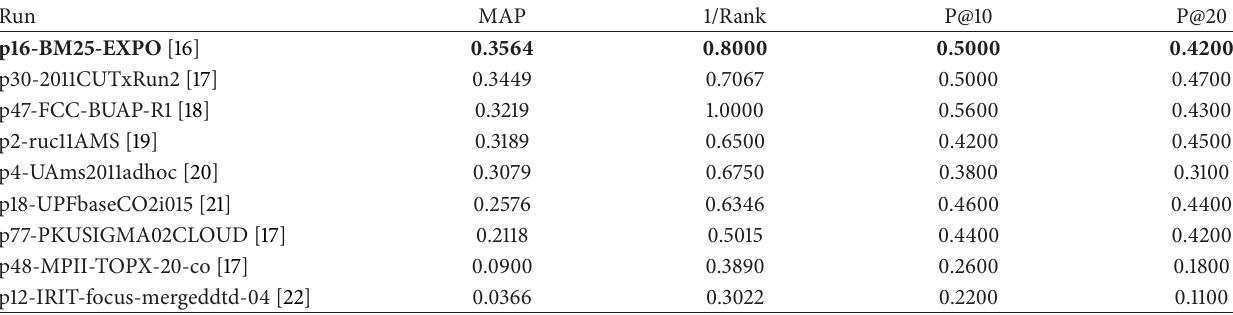
Figure 4: An Example of Exponentiation processing. Table 7: Best performing runs based on MAP over the information topics.